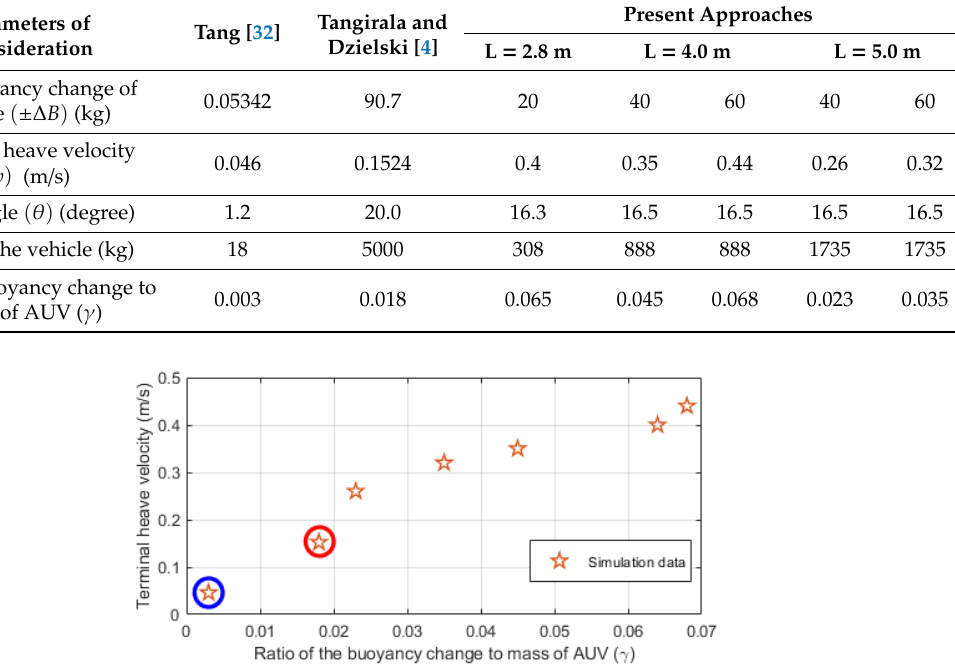
Figure 19. Ratio of the buoyancy change to mass of the AUV vs. terminal velocity (Note: Blue circle mark represents the result of Tang [32], Red circle mark represents the results of Tangirala and Dzielski [4], and all the others un-circled are our results).